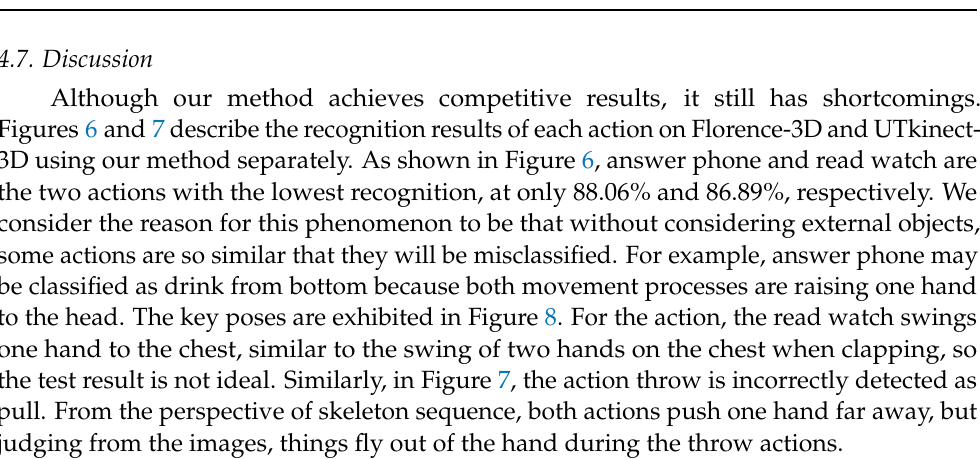
Figure 7. The recognition accuracy of each action on UTkinect-3D dataset using our method. ( a ) ( b ) Figure 8. Five key poses of two similar actions in the Florence-3D. ( a ) Drink from bottom. ( b ) Answer phone. 5. Conclusions In this paper, we proposed a novel human action recognition approach in which skel- eton sequences are transformed into color motion images, and a shallow CNN model is introduced for action classification. For each action sequence, three relative features with informative spatial-temporal information are calculated to depict human motions. Next,